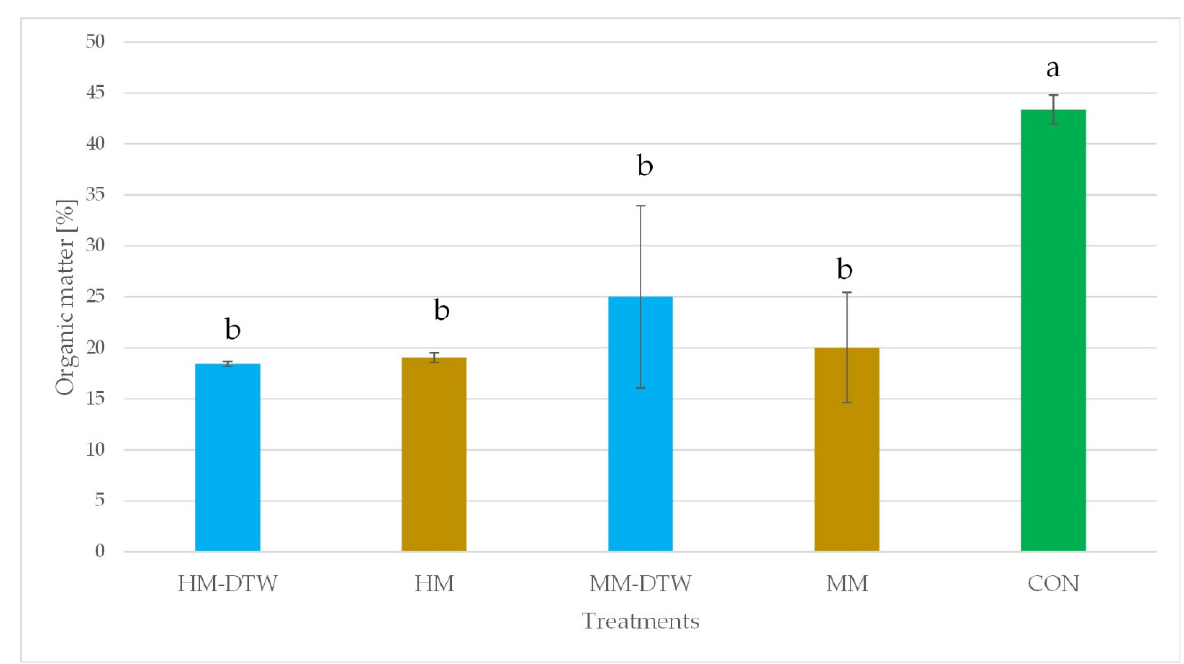
Figure 4. Organic matter for the different treatments. Obtained p -value from ANOVA was p = 0.00001. Different letters indicate homogeneous groups ( p < 0.05) according to HSD Tukey test (HM-DTW—areas identified as sensitive by DTW algorithm and harvested with high mechanisation level; HM—areas not identified as sensitive by DTW algorithm and harvested with high mechanisation level; MM-DTW—areas identified as sensitive by DTW algorithm and harvested with medium mechanisation level; MM—areas not identified as sensitive by DTW algorithm and harvested with medium mechanisation level; CON—control area consisting of unharvested oak coppice in the last 20 years located close to the two parcels). Different lowercase letters indicate different homogeneous groups at p < 0.05 according HSD Tukey